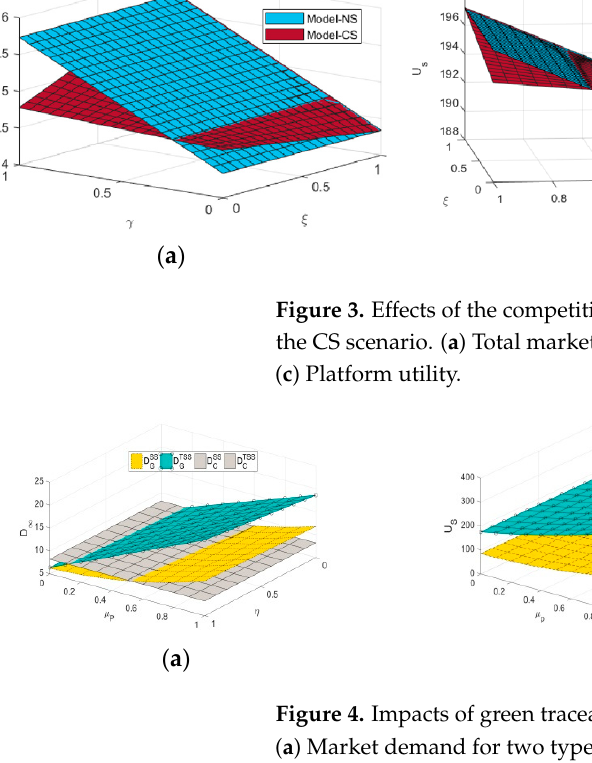
Figure 3. Effects of the competition intensity and the consumer subsidy ratio on performances under the CS scenario. ( a ) Total market demand for two types of agricultural products . ( b ) Supplier utility . ( c ) Platform utility .